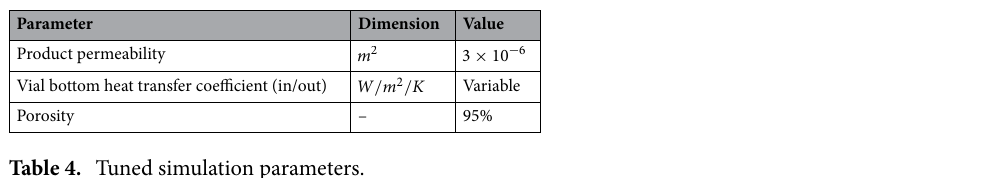
Table 4. Tuned simulation